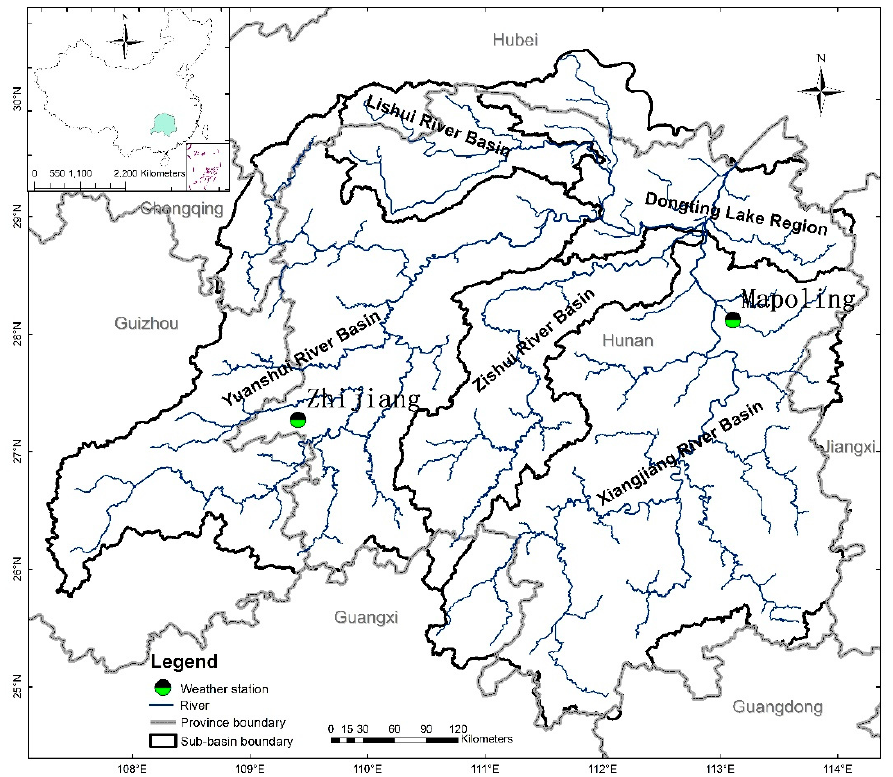
Figure 3. The location of the Mapoling and Zhijiang weather stations.